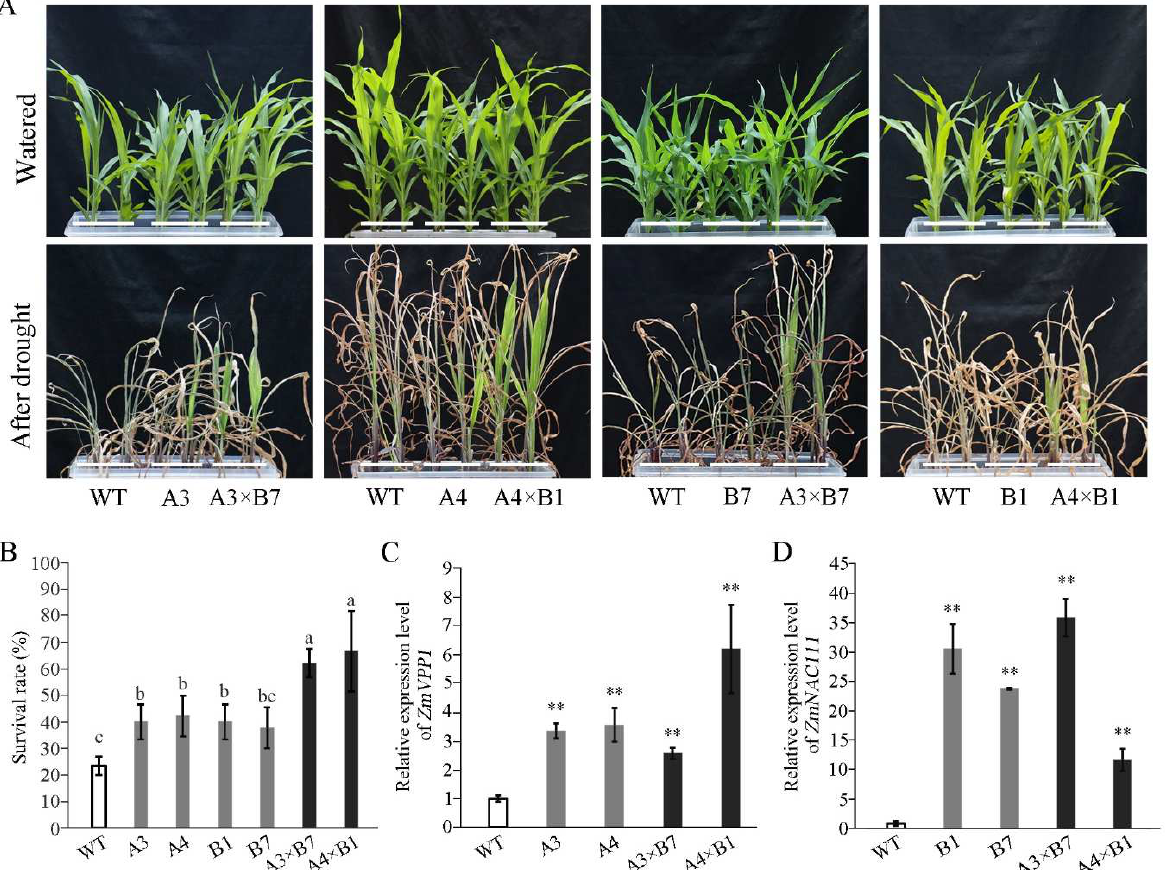
Figure 1. Analysis of drought resistance at seedling stage. ( A ) Representative photographs of maize seedlings before and after drought treatment. ( B ) Statistical analysis of seedling survival rates. 54 seedlings from each line were examined in three independent tests. Different letters indicate significant differences. ( p < 0.05, one-way ANOVA using Tukey’s multiple comparison tests in SPSS17.0). ( C , D ) ZmVPP1 and ZmNAC111 transcript levels in transgenic and WT maize. Data are average of three independent tests ±